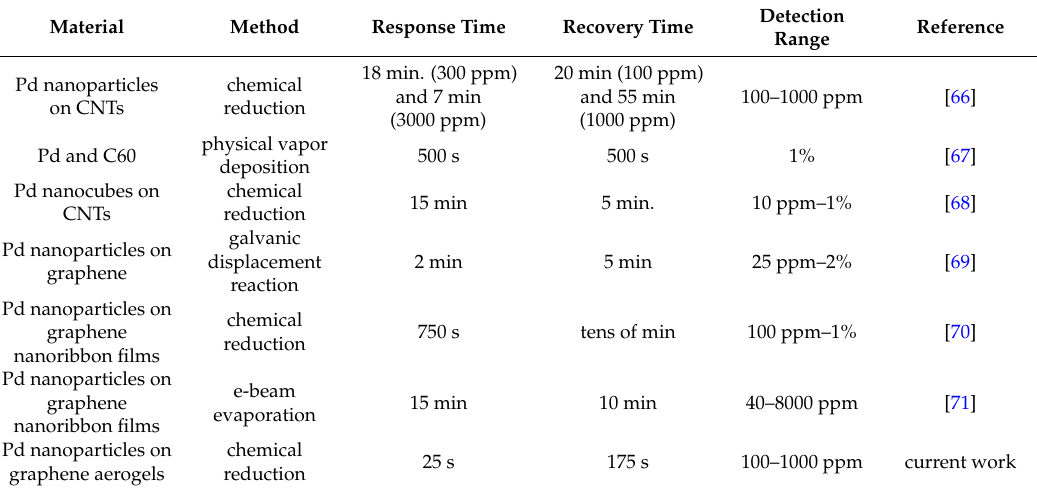
Figure 8. ( a ) The change of resistance of GA/Pd nanoparticle composites with different Pd loadings upon exposure to 1000 ppm hydrogen gas. ( b ) The change of resistance of GA/Pd nanoparticle composites upon hydrogen gas on/off cycles. Table 1. Comparison of hydrogen gas sensing performance.